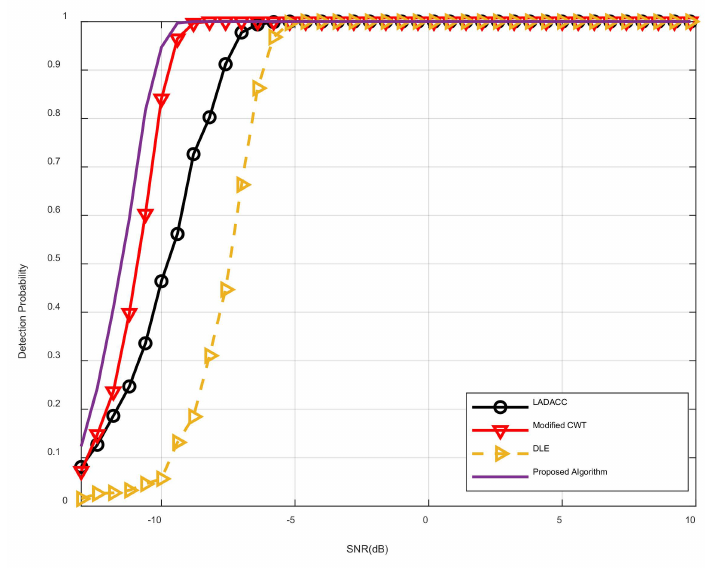
Figure 14. Detection probability with SNR